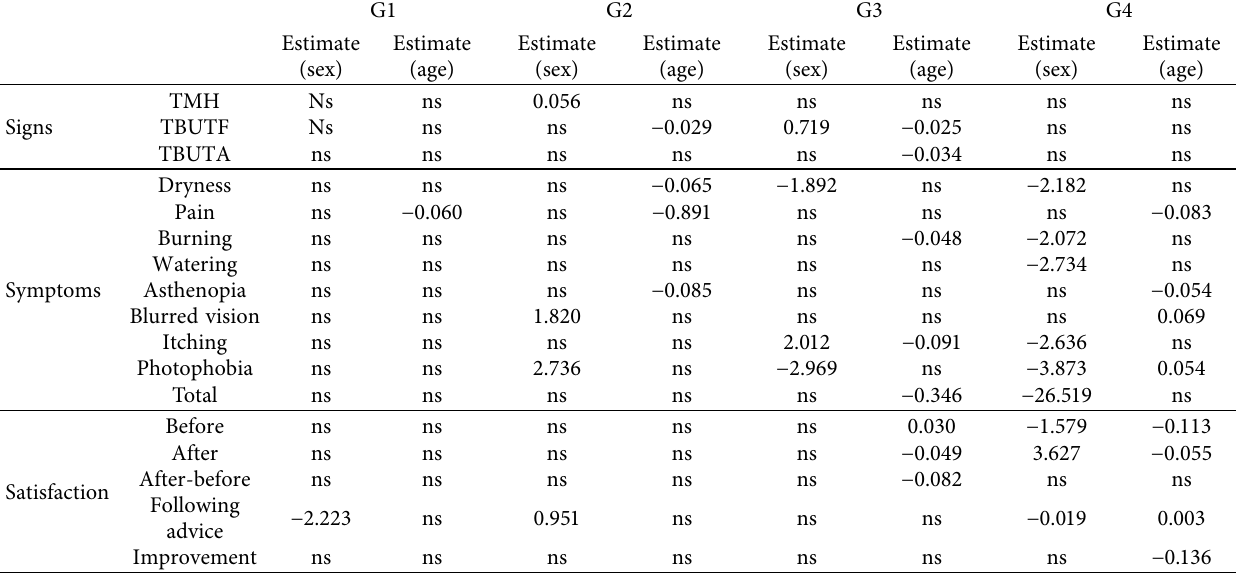
Table 4: The correlations between pre- and posttreatment signs/symptoms/treatment satisfaction scores and